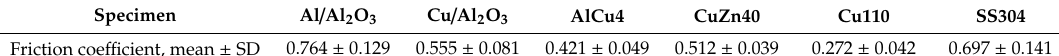
Table 4. The friction coe ffi cient of tested samples.